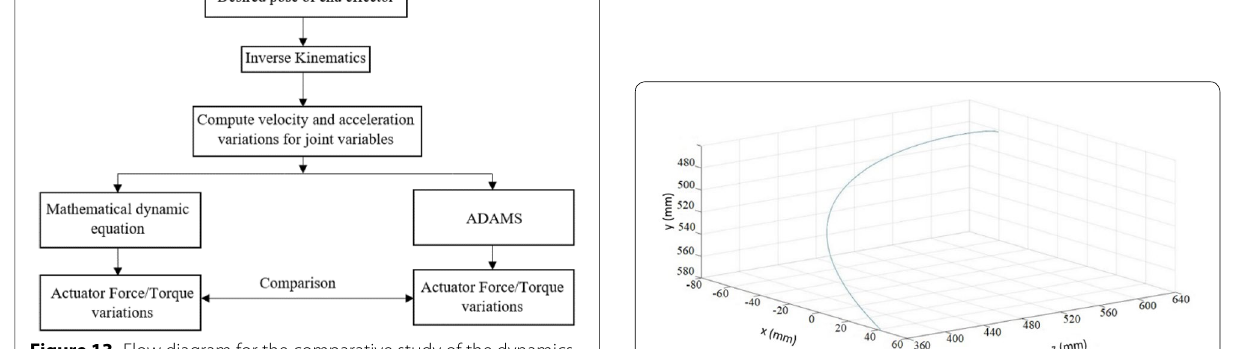
Figure 13 Flow diagram for the comparative study of the dynamics simulation Figure 14 End effector cubic trajectory from initial to final